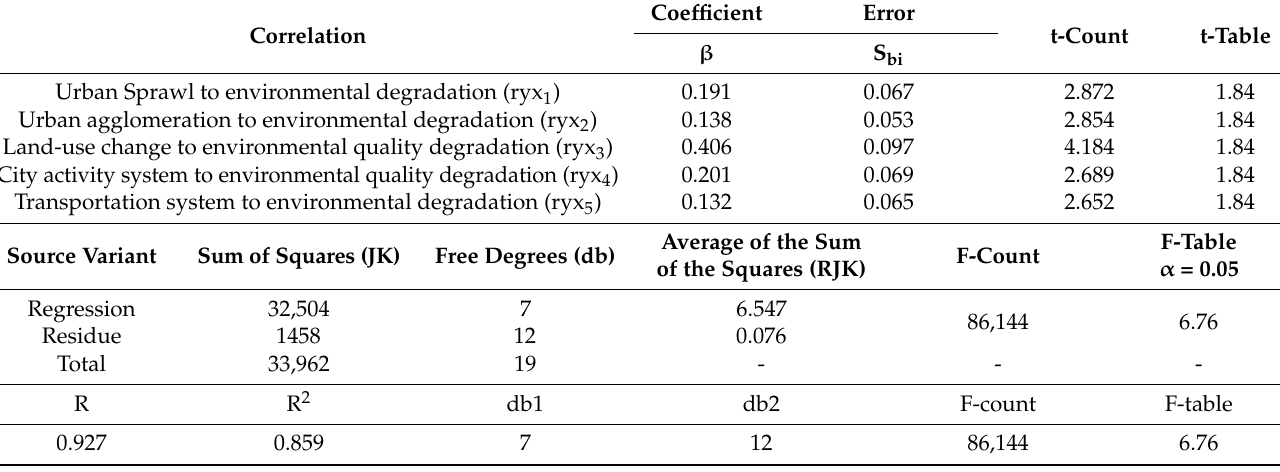
Table 7. Summary of test results for the significance of multiple regression